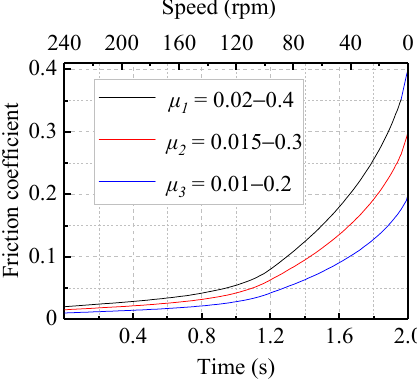
Figure 4. The curves relating the time, speed, and friction coefficient.